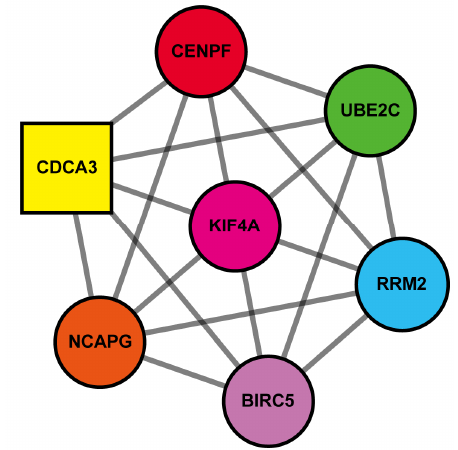
Figure 5. Clustered DEGs identified by using MCODE in PPI network. Seven nodes and twenty–one edges were identified. Square shape node is a seed node, and other nodes have same score.